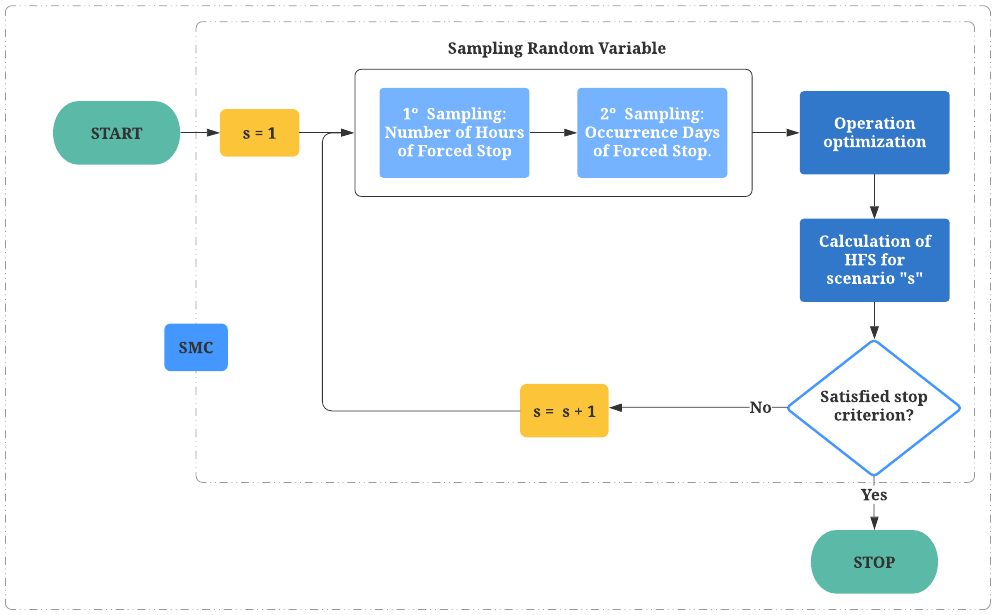
Figure 3. Flowchart of the Proposed Monte Carlo